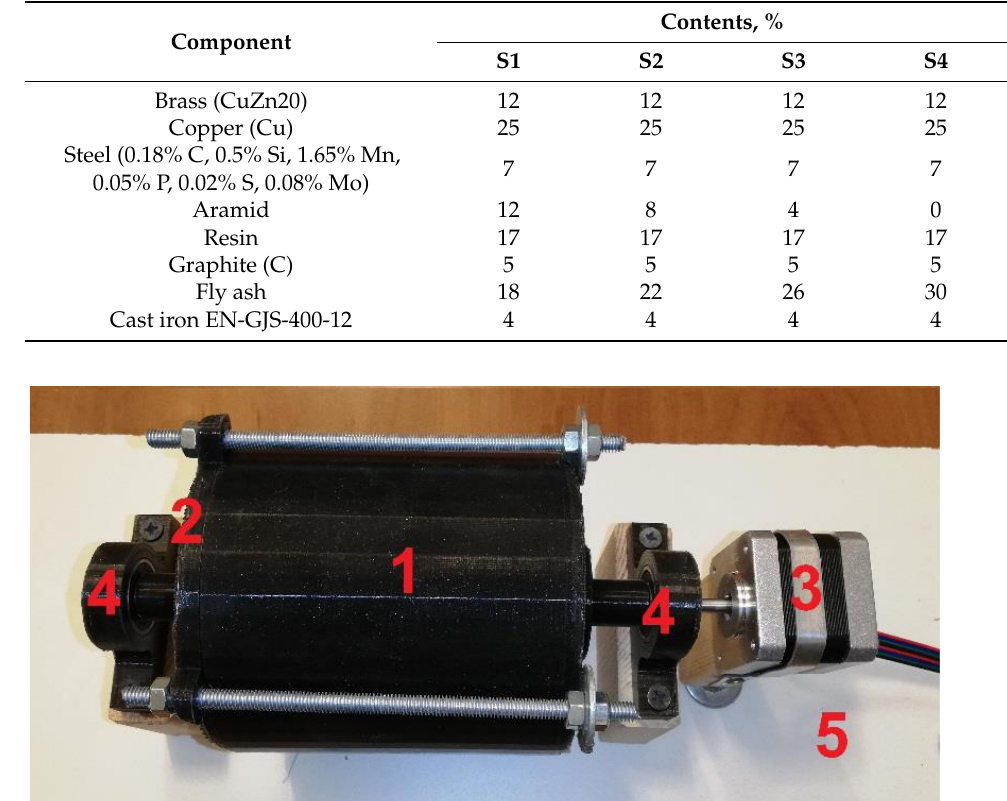
Figure 1. The 3D-printed mixer used in material preparation process: 1 — container with mixing blades inside, 2 — cover, 3 — steeper motor (for precise rotation controlling), 4 — bearing, 5 — base.